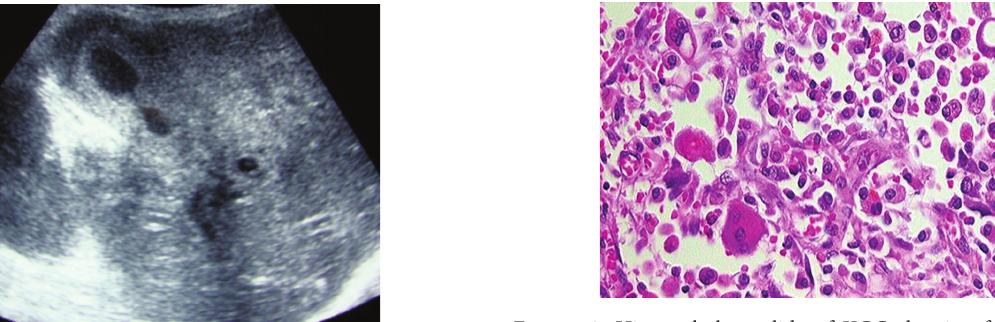
Figure 3: Histopathology slide of XGC showing foamy macro- phages and giant cells in the wall of the gallbladder.